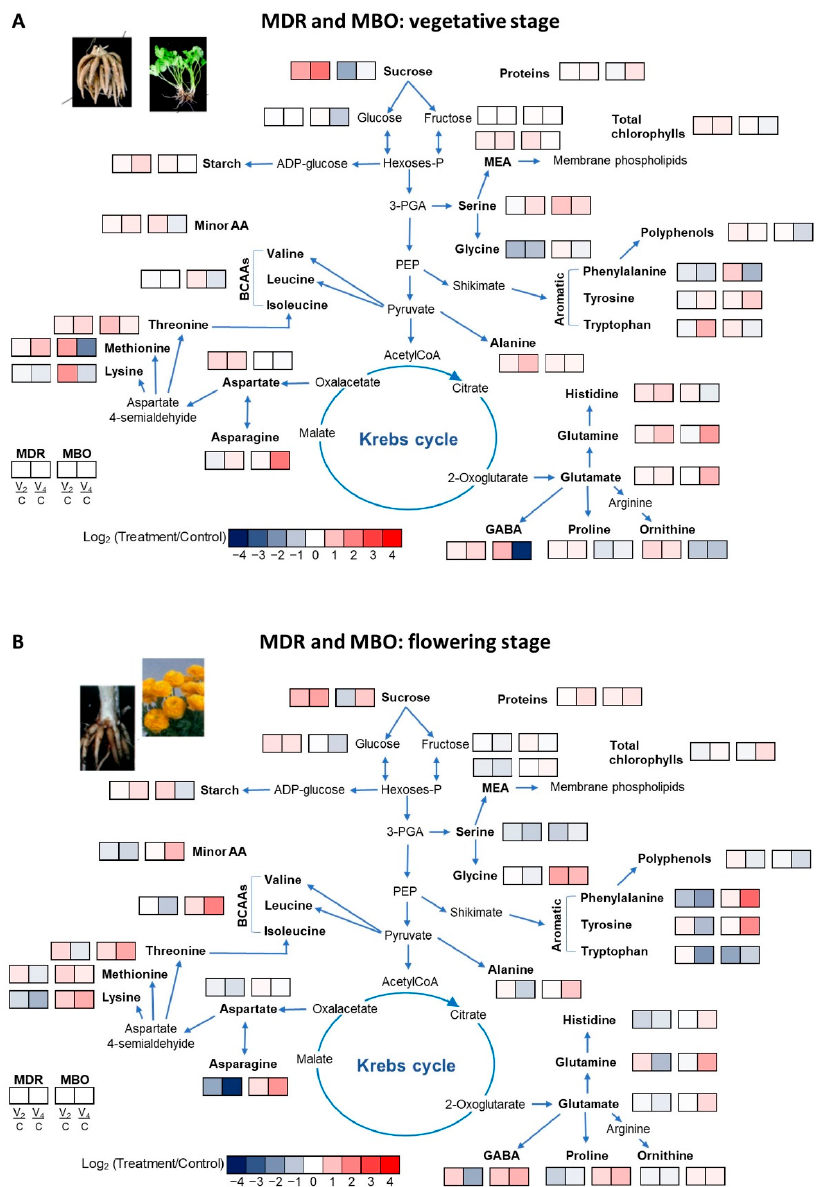
Figure 2. Pathway map summarizing the effect in vegetative ( A ) and flowering ( B ) stage in plants of Ranunculus asiaticus L. hybrids MDR and MBO, obtained by three preparation procedures of tuberous roots, only rehydration (Control, C), rehydration plus vernalization for 2 weeks (V2), rehydration plus vernalization for 4 weeks (V4). Plants at vegetative phase (Week 8 from planting). The heat map results were calculated as Logarithm base 1.5 (Log 1.5) V2/Control and V4/Control values for the two hybrids and visualized using a false-color scale, with red indicating an increase and blue a decrease. The significant ratios were indicated in the squares.